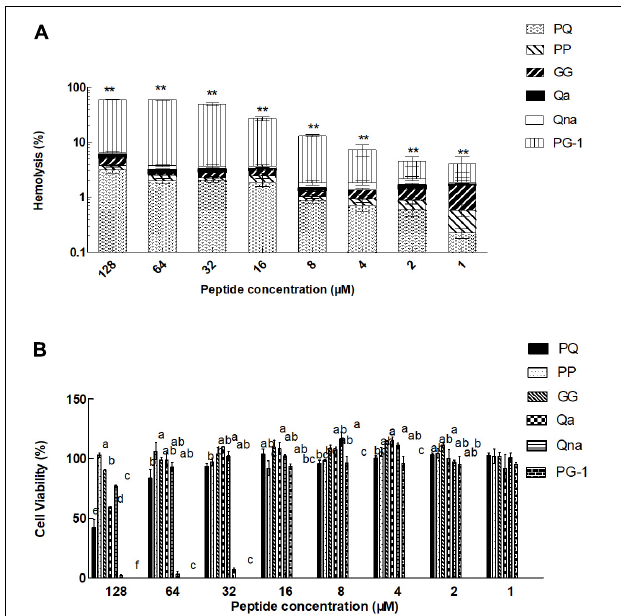
FIGURE 4 | Eukaryotic cells toxicity of peptides against hRBCs (A) and IPEC-J2 cells (B) . ∗∗ P < 0.01, compared to values for PG-1 (A) . Means in the same concentration with different superscript indicate a very significant difference ( P < 0.01) (B) . The graphs were derived from the average of three independent